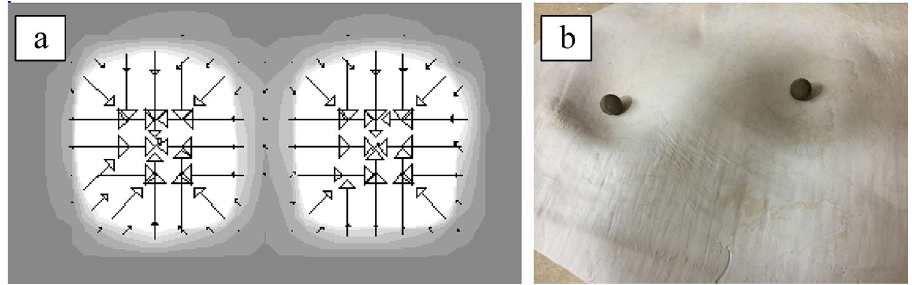
Figure 2. External ischial tuberosity width (EITW) estimation in the seated pressure method ( a ) and the complete EITW imprint in clay in the impress method ( b ).